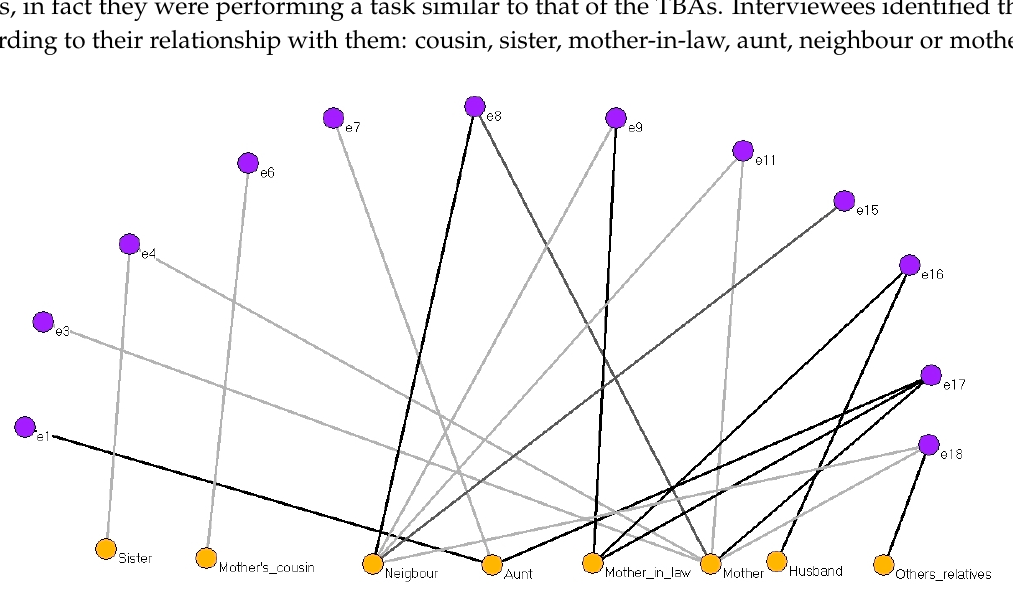
Figure 5. Two-mode network of care provided by family members or friends when delivery occurred at home.